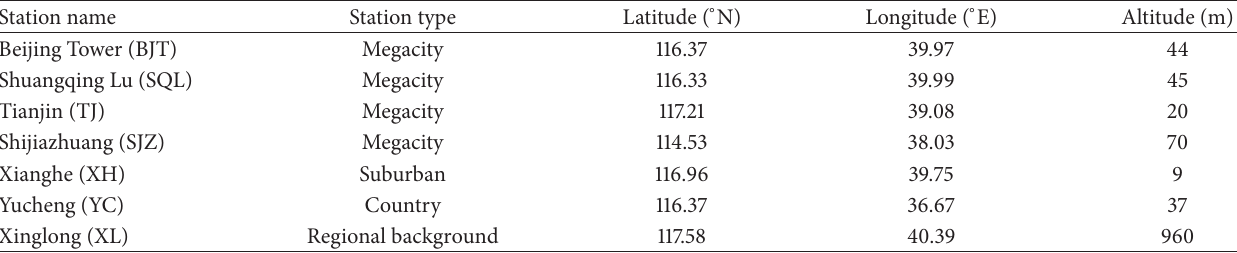
Table 1: Locations of air quality sites over the BTH